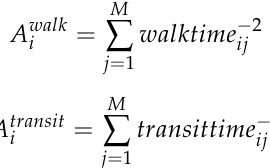
Figure 3. ( a ) The ratio of Korean population to Japanese population at the neighborhood level; ( b ) A kernel density estimation map of 3598 jobs in the study area. 5.2. Parcel-Level Job Accessibility Results This subsection reports walk-based and transit-based job accessibility that was meas- ured at the parcel level. Table 1 reports the descriptive statistics. The average transit-based job accessibility is approximately 32% higher than the average walk-based job accessibil- ity. The t -test result indicates that transit-based accessibility is significantly ( p < 0.001) higher than walk-based accessibility. Given the fact that our study focuses on colonial Seoul in the 1930s (almost 90 years ago at the time of writing this manuscript), it is inter- esting to observe that the transit-based job accessibility was higher than the walk-based job accessibility, which is similar to what we can observe in cities nowadays. This means that public transportation was a travel option that was faster than walking in colonial Seoul in the 1930s. Table 1. Descriptive statistics of walk-based and transit-based job accessibility measured at the par- cel level. Min Max Median Standard Deviation Mean Walk-based job accessibility ( 𝐴 (cid:3036)(cid:3050)(cid:3028)(cid:3039)(cid:3038) )